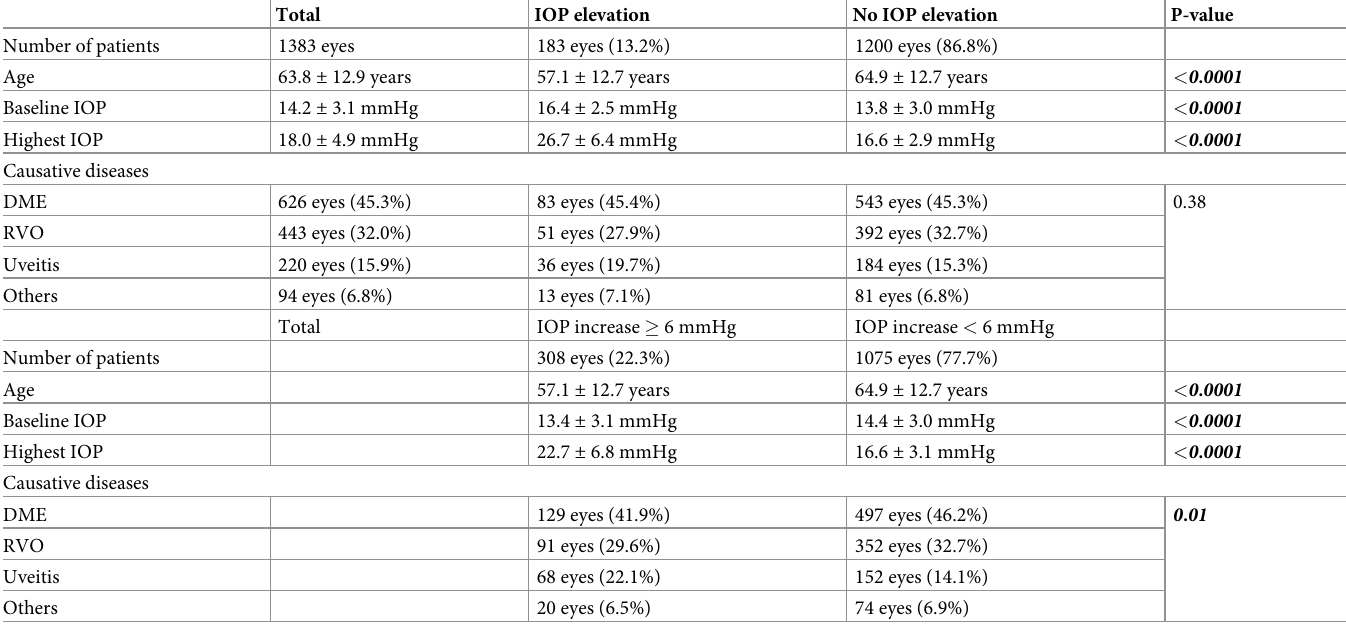
Table 4. Analyses of IOP elevation and IOP increase with a fixed steroid dose (TA = 20